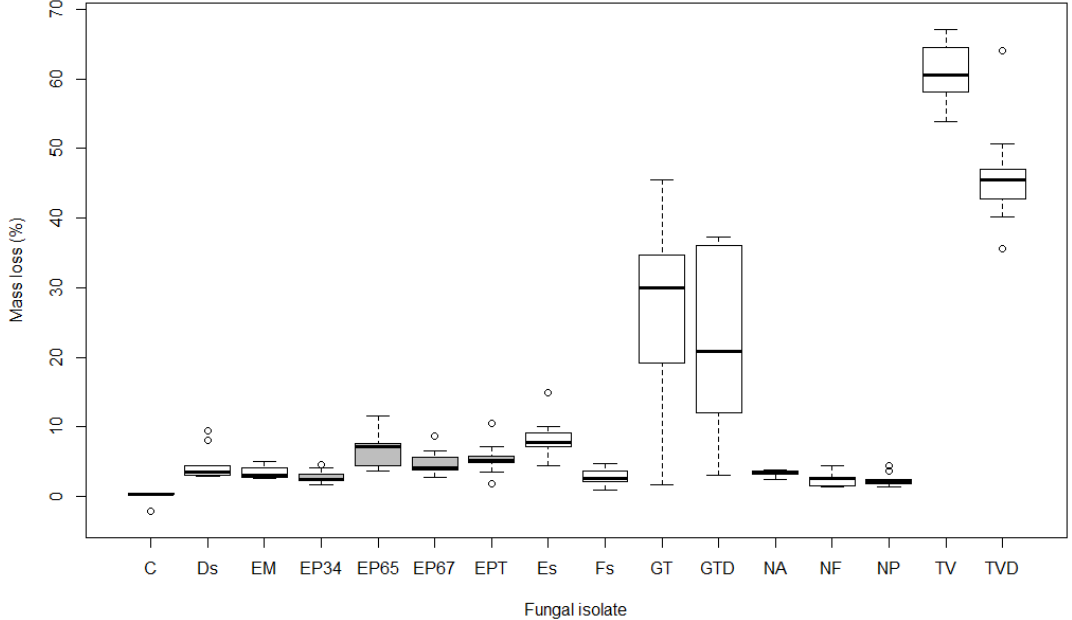
Figure 3. Boxplot showing mass loss (%) after 15 weeks of exposure to different fungal isolates in Acer campestre (see Table 1 for labels of isolates; boxes of E. parasitica isolates are grey). Boxplot represents minimum, first quartile (Q 1 ), median, third quartile (Q 3 ), and maximum